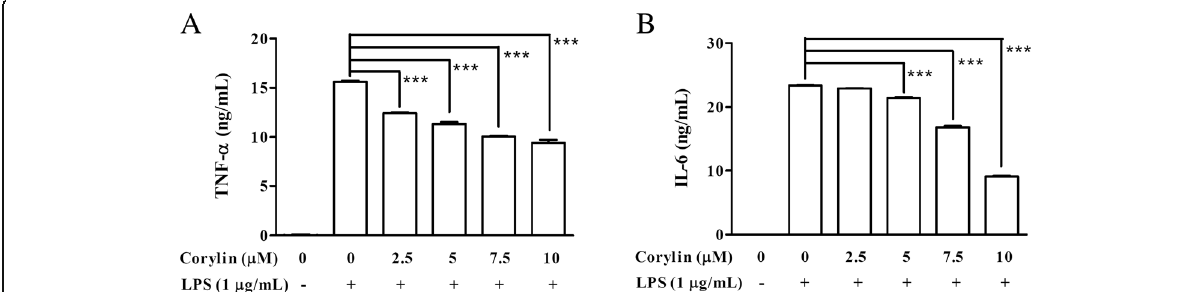
Fig. 2 Effects of corylin on the production of proinflammatory cytokines by LPS-activated BV2 cells. BV2 cells were pre-treated with various doses of corylin for 1 h, and then treated with LPS (1 μ g/mL) for 24 h. The expressions of a TNF- α and b IL-6 in the cell culture supernatant were analyzed using ELISA. Data represent mean ± SD of three independent experiments (*: p < 0.05; **: p < 0.01; ***: p < 0.001 vs. LPS